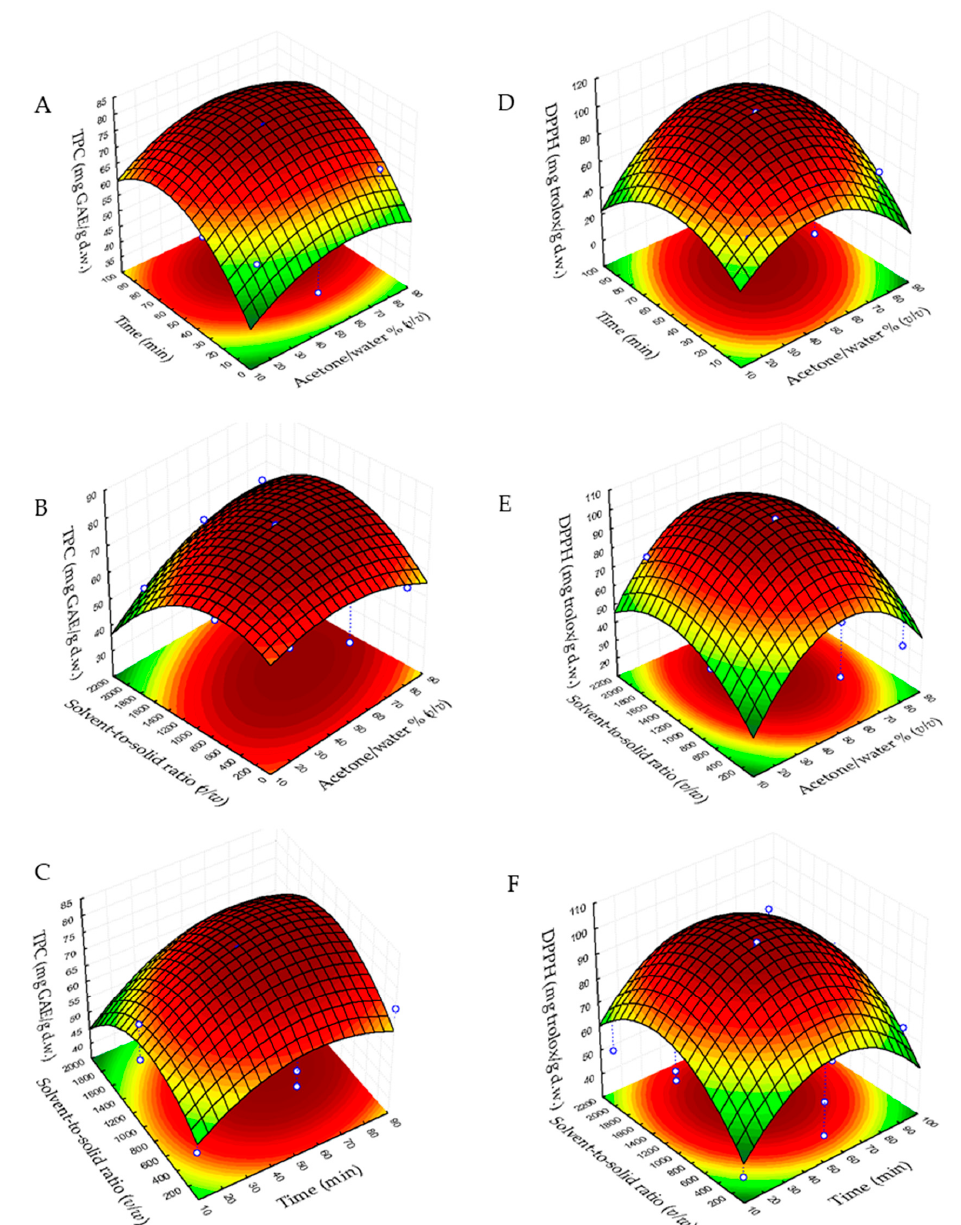
Figure 1. Response surface plots showing combined effects of process variables for total phenolic content and DPPH assay. ( A , D ) Solvent-to-solid ratio ( v/w ) vs. acetone/water % ( v/v ); ( B , E ) acetone/water ( v/v ) vs. time; and ( C , F ) solvent-to-solid ratio ( v/w ) vs. time.